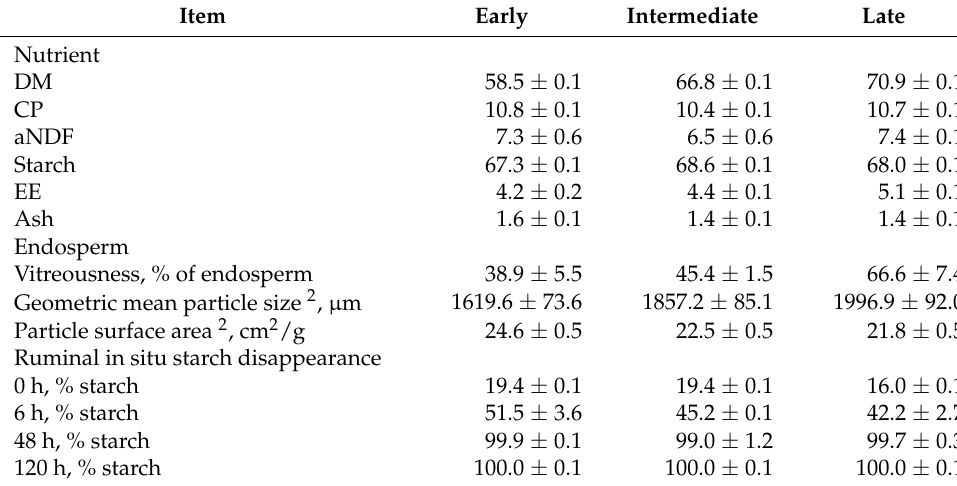
Table 2. The chemical composition, particle size, and in situ starch disappearance of unfermented maize kernels ( n = 2 for each maturity) 1 . Item Early